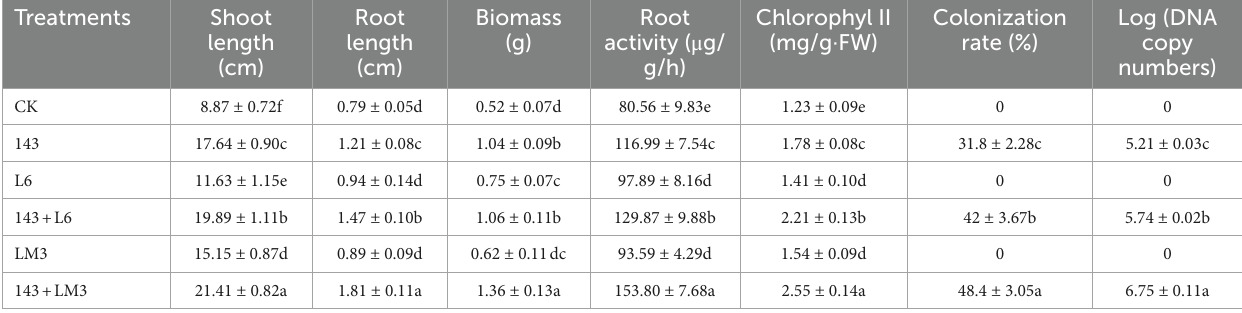
TABLE 1 Effect of the ericoid mycorrhizal fungi Oidiodendron maius 143 coinoculated with L6 or LM3 isolates on the plant growth and colonization rate.